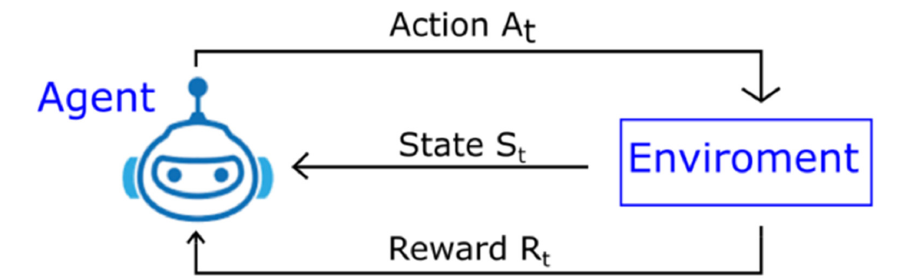
Figure 12. Reinforcement learning. Table 3. Application of ML methods in UAV-related